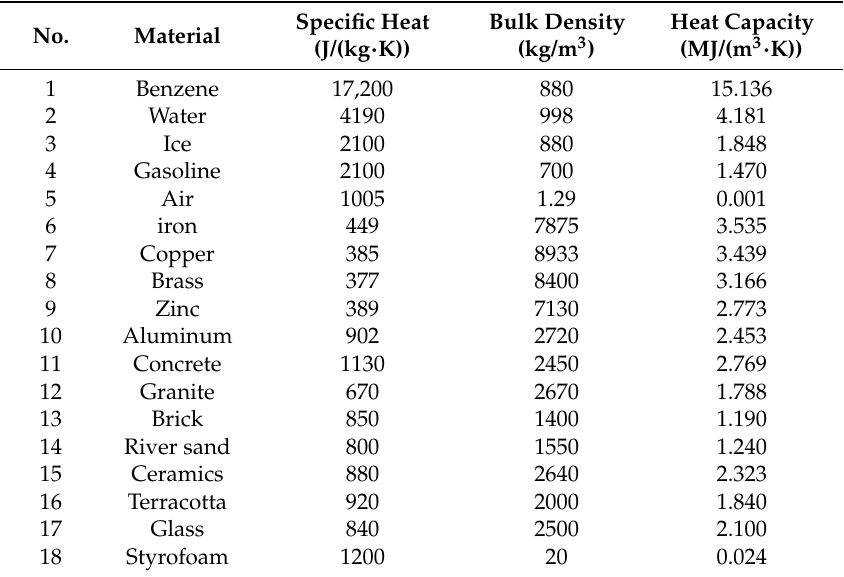
Table 1. Specific heat, bulk density, and heat capacity of different materials